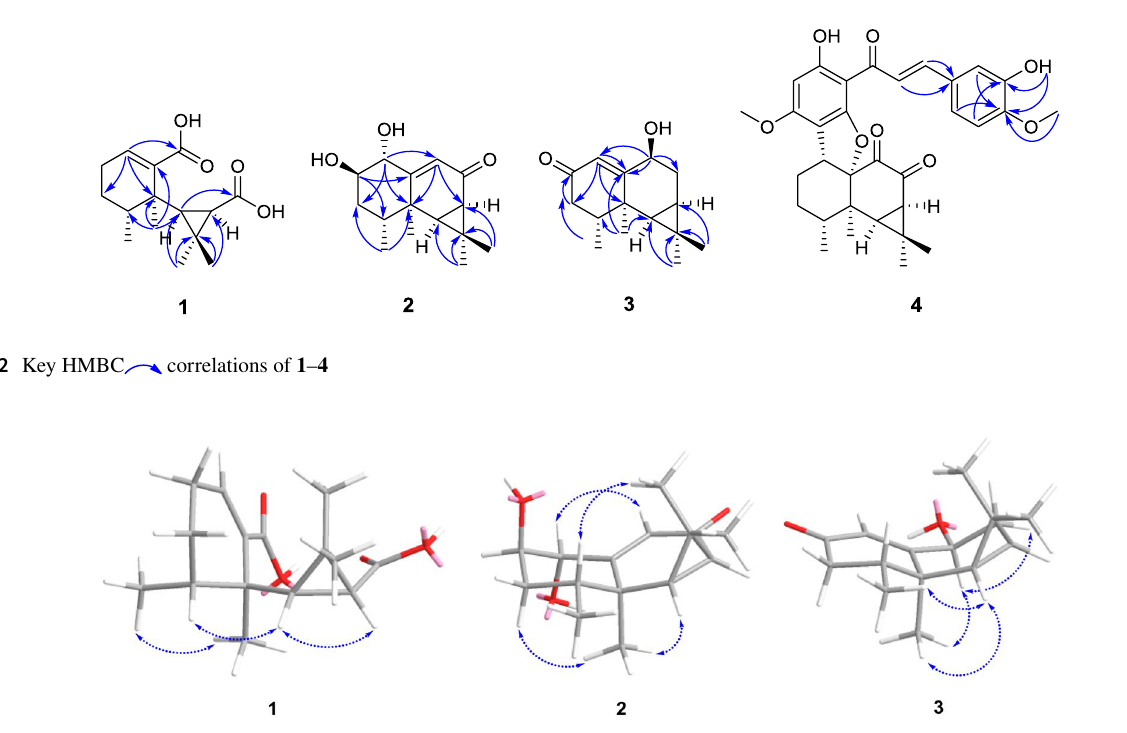
suggesting a molecular formula of C C H O Na, 289.1410), while for aristolanhydride, a 15 22 4